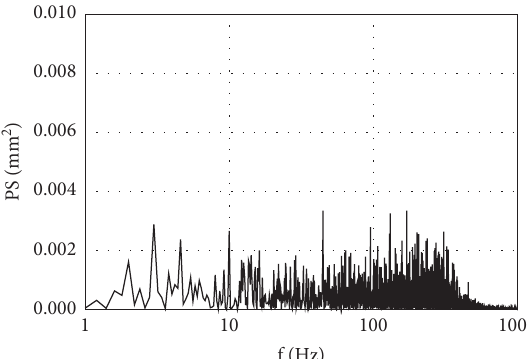
Figure 11: Power spectrum of shock oscillations for roughness at X / C � 0.11 and Ra � 10 μ m.